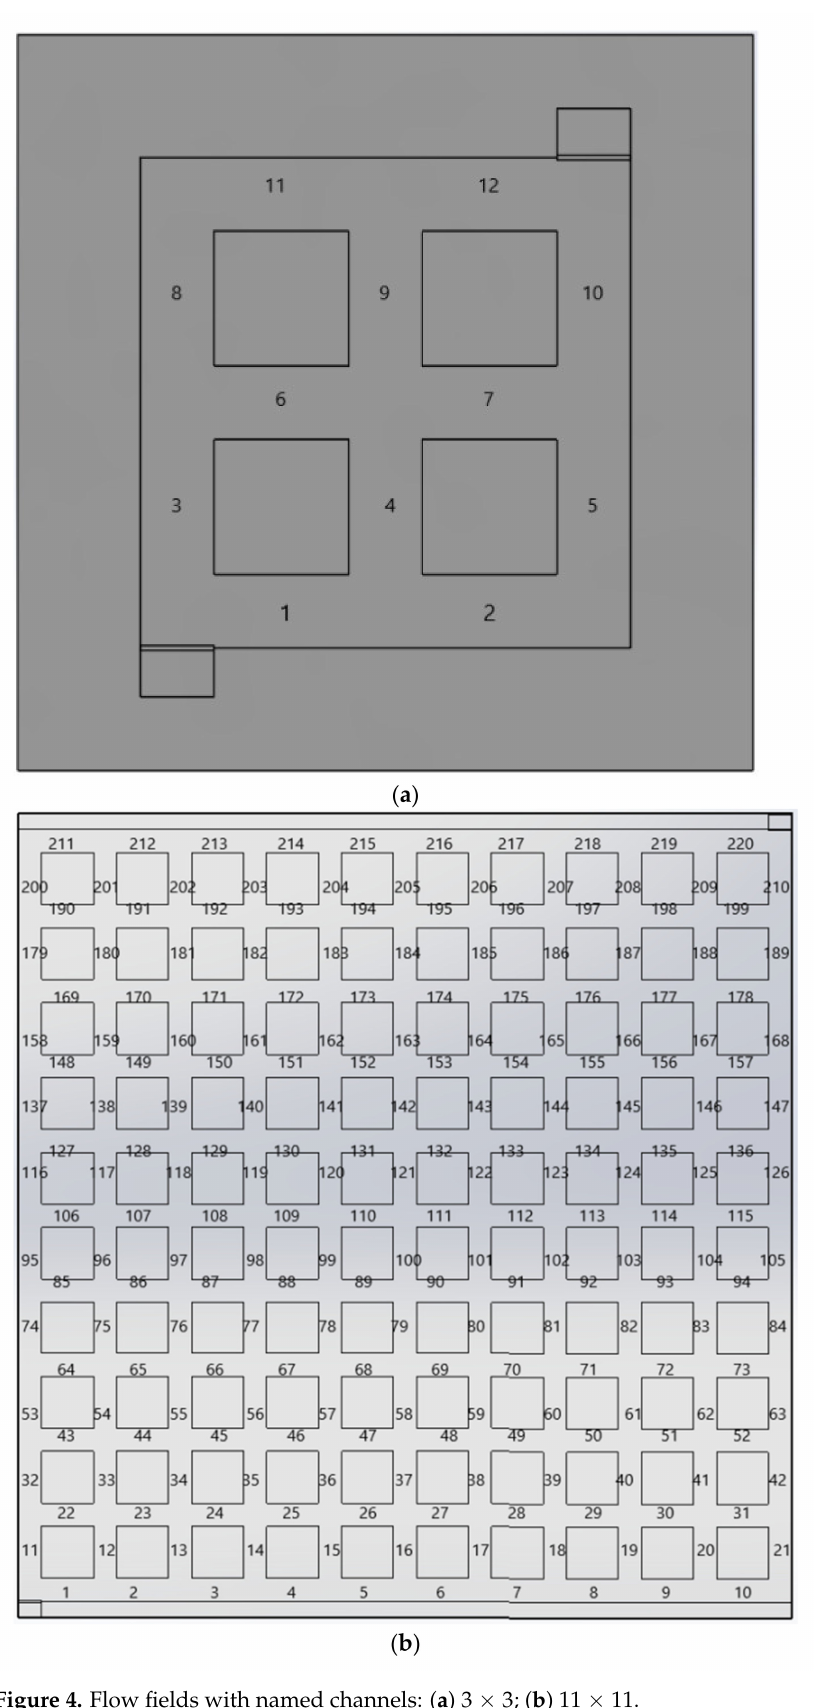
Figure 4. Flow fields with named channels: ( a ) 3 × 3; ( b ) 11 ×